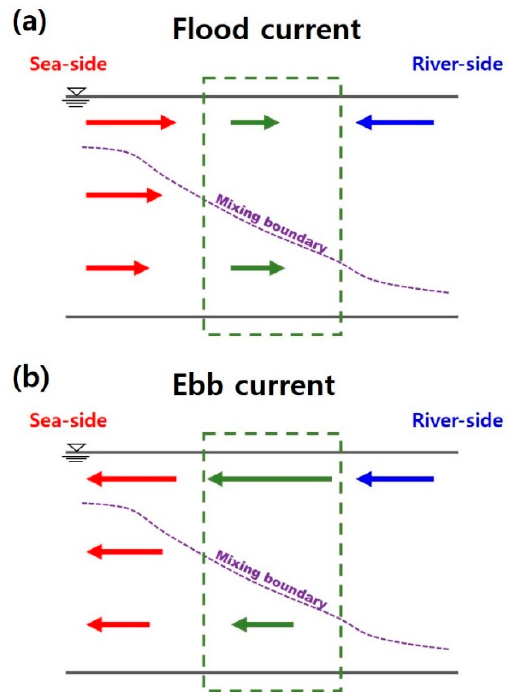
Figure 5. Vertical profile of current during ( a ) flood tide and ( b ) ebb tide. Table 1. Comparison of the ratio of the averaged upper flow velocity to the averaged lower flow velocity. Dry Period Rainy Tidal Period